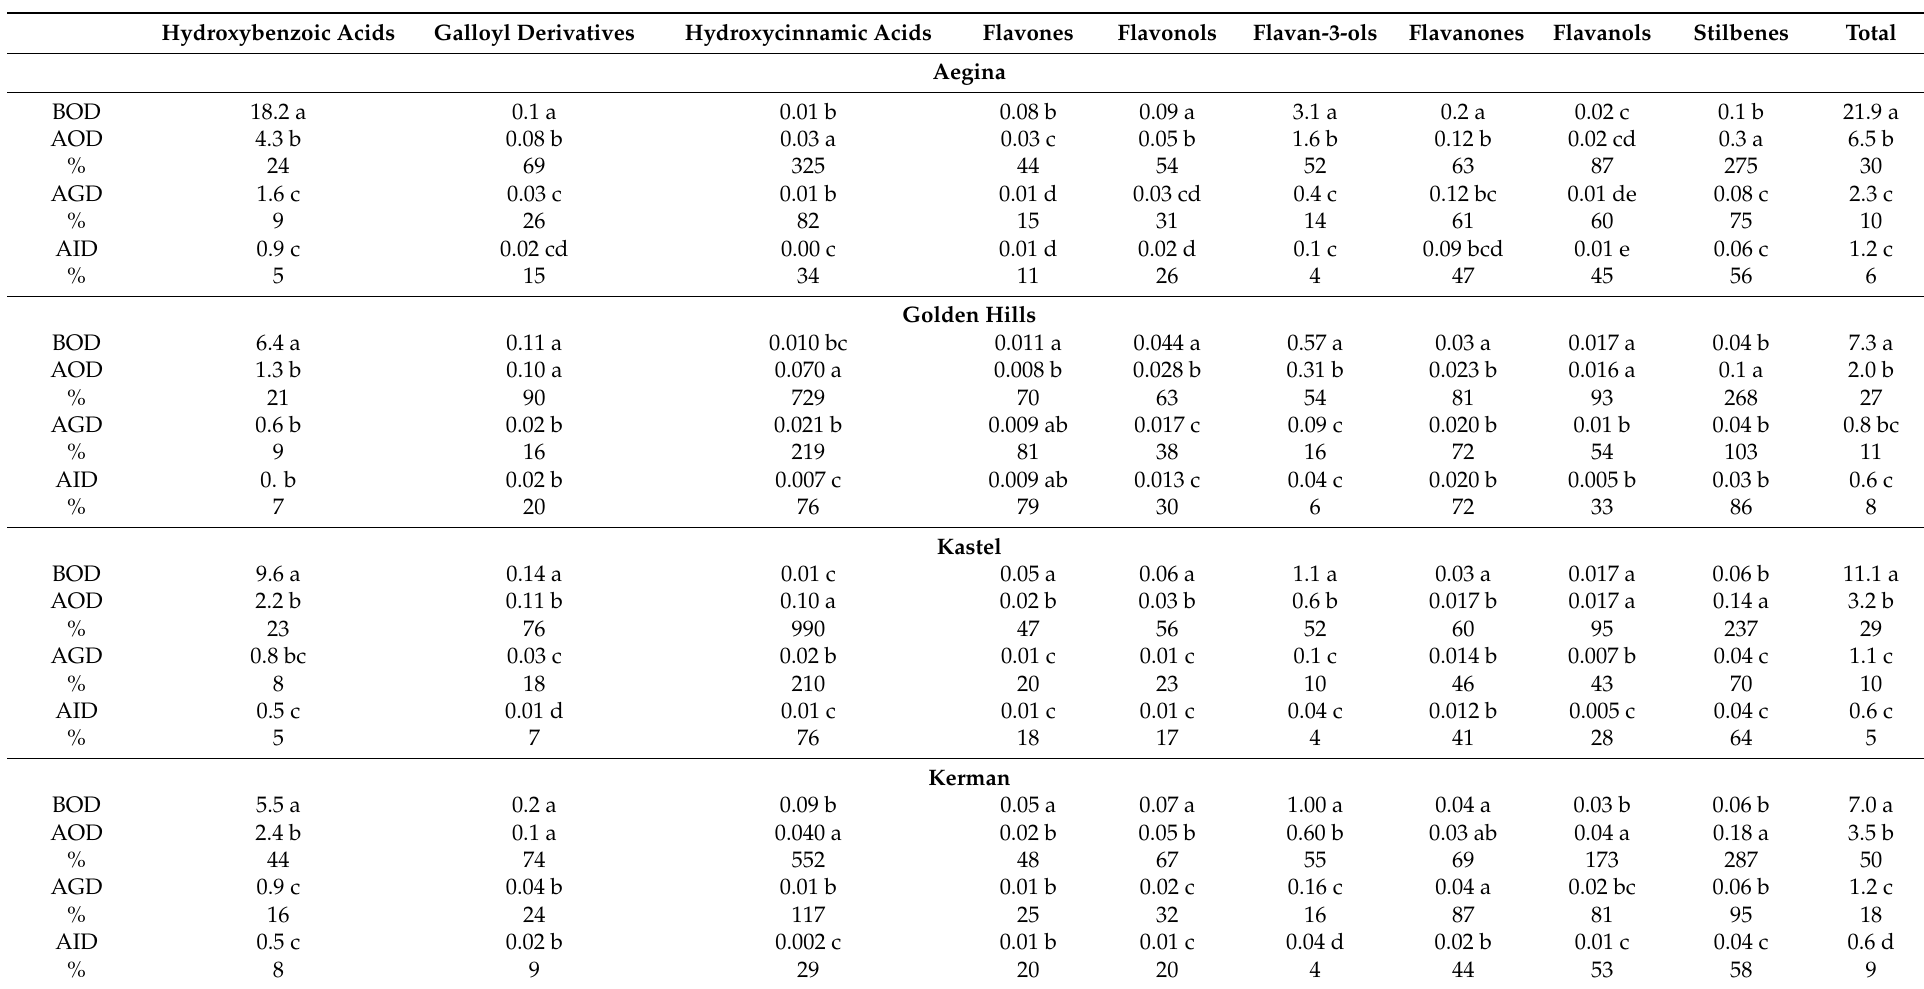
Table 1. Polyphenol families quantified by pistachio varieties before and after oral, gastric and intestinal in vitro digestion (nmol/g DW). Hydroxybenzoic